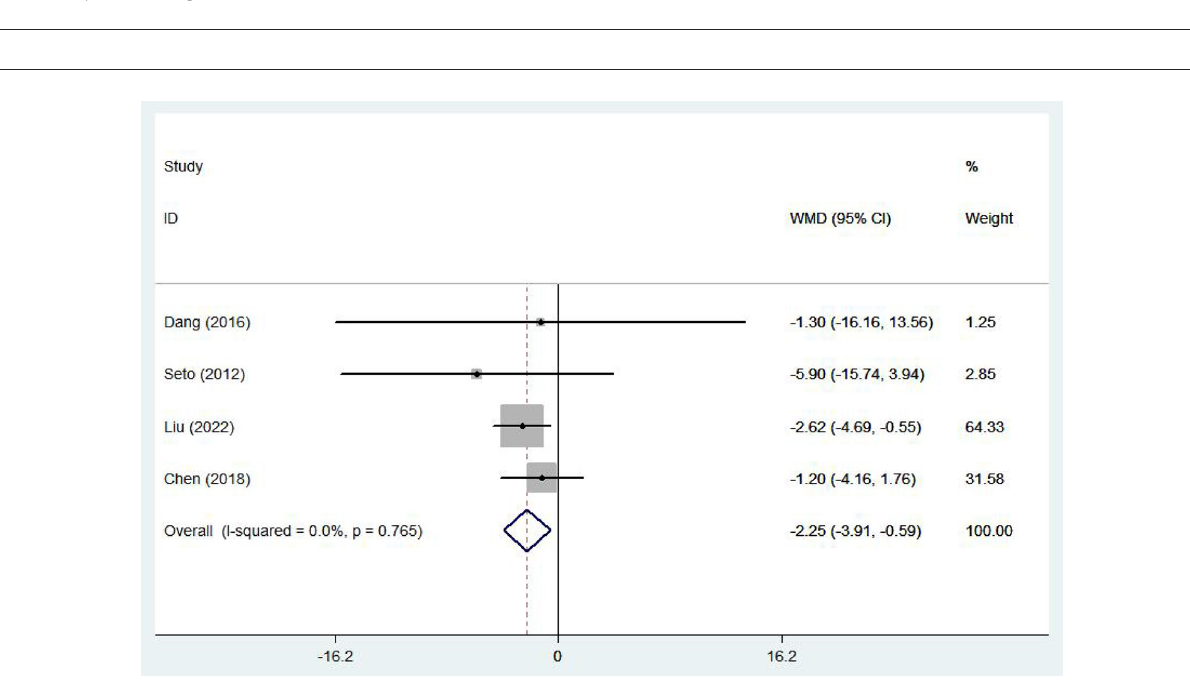
FIGURE11 Forest plots showing the effects of MLHFQ.